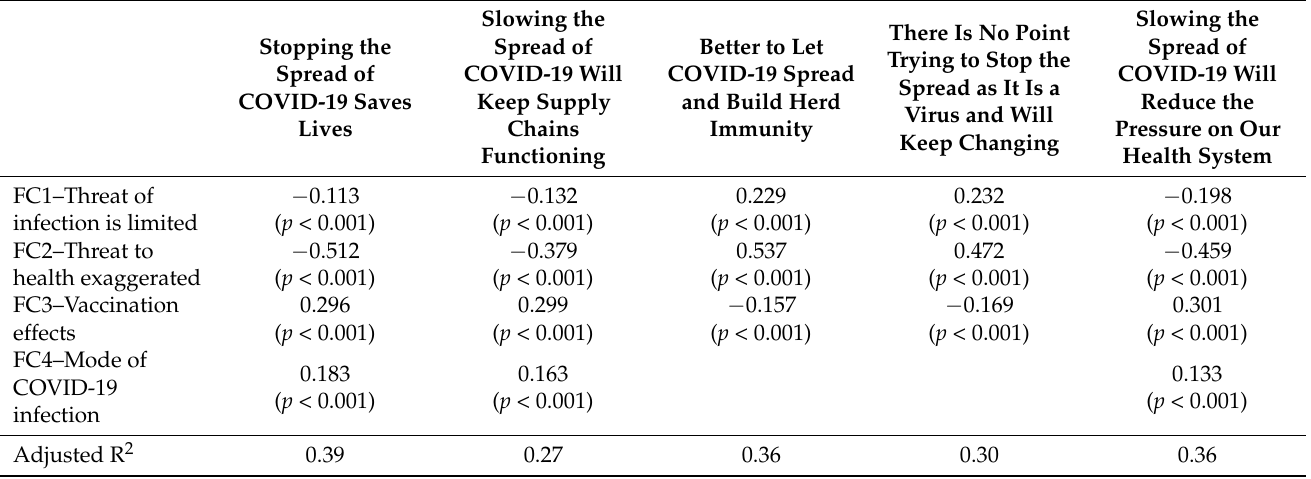
Table 5. Standardised parameter estimates for beliefs about preventing the spread of